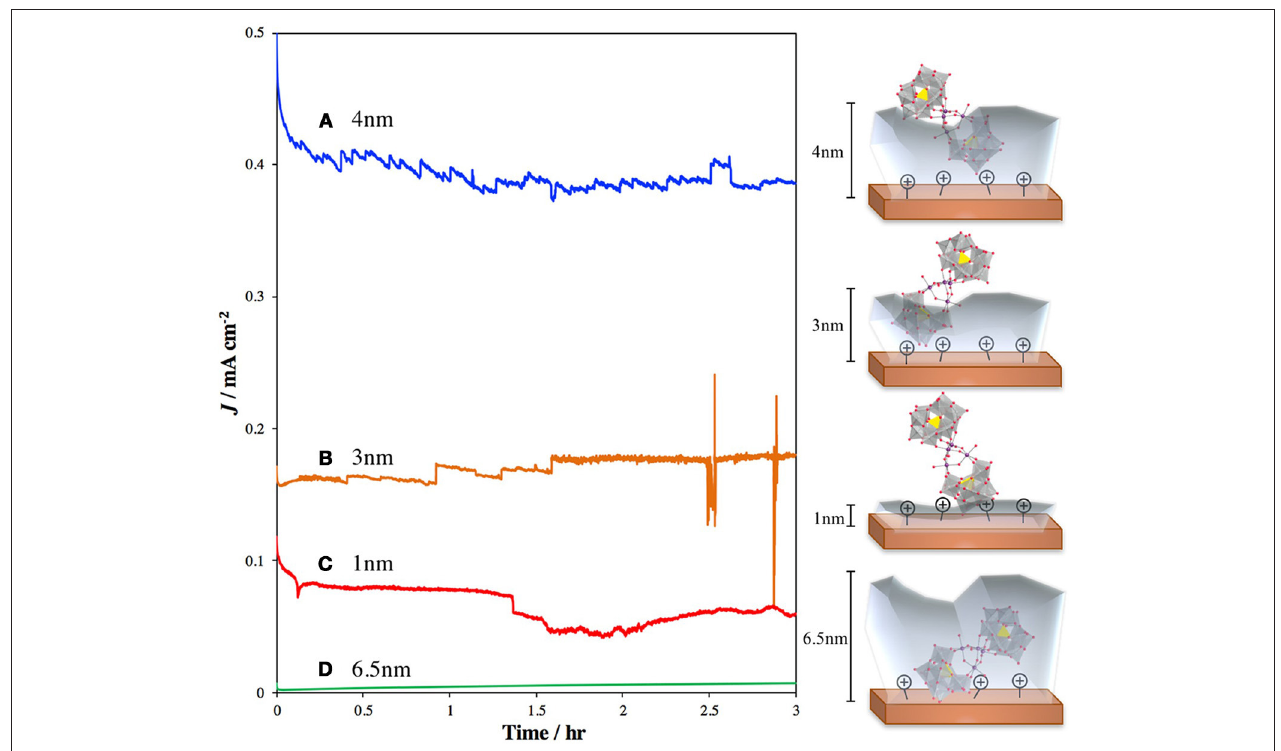
FIGURE 5 | Current densities and schematic illustrations of photoanodes composed of hematite–APS–Ru 4 Si 2 -Al 2 O 3 atomic layer deposition thickness of (A) 4nm (blue line); (B) 3nm Al 2 O 3 (orange line); (C) 1nm Al 2 O 3 (red line); and (D) 6.5nm Al 2 O 3 (green line) (Lauinger et al., 2017a). The translucent gray layers represent the depth of the Al 2 O 3 coating.Reprinted with permission from ACS Appl. Mater. Interfaces , 2017 9 (40), 35048–35056. Copyright 2017, American Chemical Society.